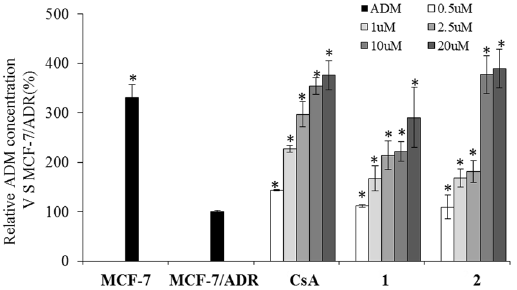
Figure 6. Concentration-dependent inhibition of Pgp-mediated ADM efflux by compounds 1 and 2 in MCF-7/ ADR. Cyclosporin A (CsA) was used as a positive control. Compounds were tested at 0.5, 1.0, 2.5, 10 and 20 μ M, respectively. ( * P < 0.001, significant differences of ADM concentration intracellular between treatment groups and DMSO vehicle control